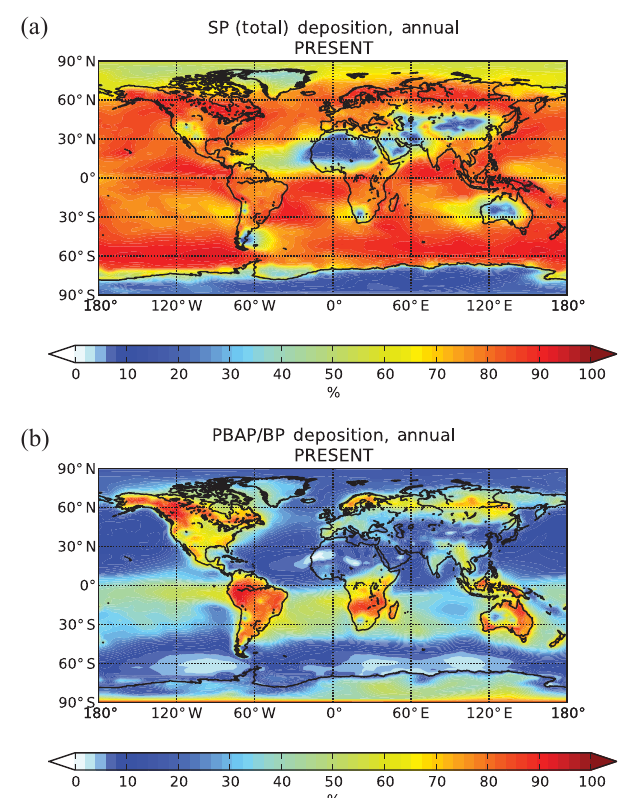
Figure 7. Annual mean percentage fractions of (a) P solubility (SP = %DP / TP) and (b) the relative contribution of PBAPs to BP, in deposited P-containing aerosols, as calculated by the TM4-ECPL model for the present atmosphere (year